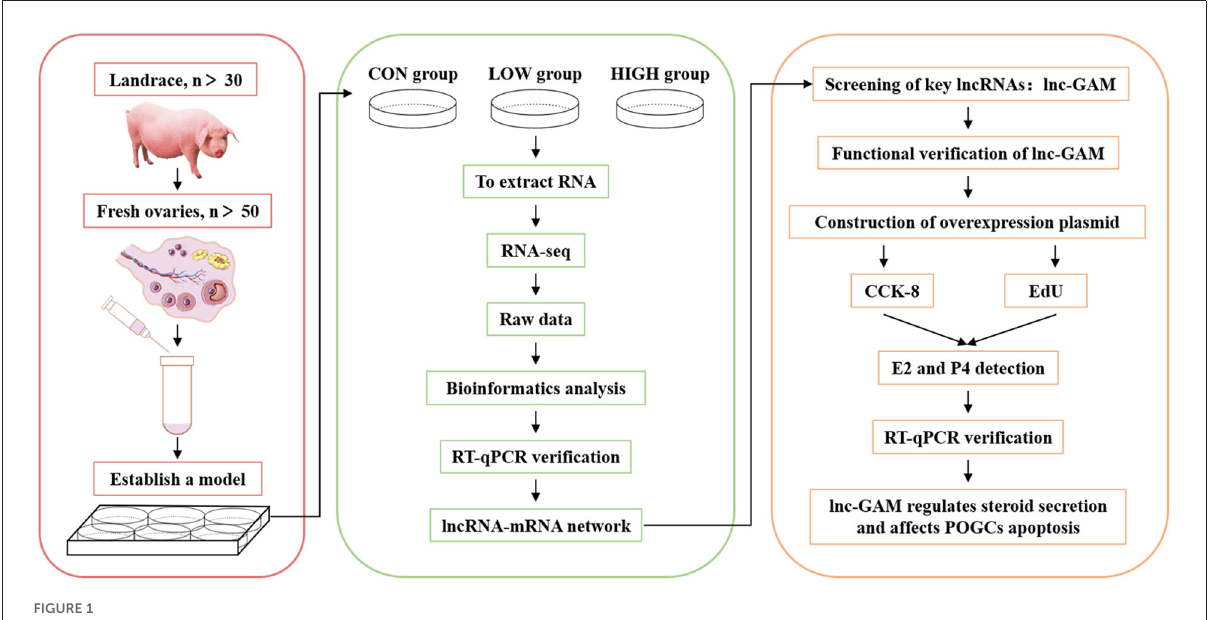
FIGURE1 Workflow chart of sequencing data processing and